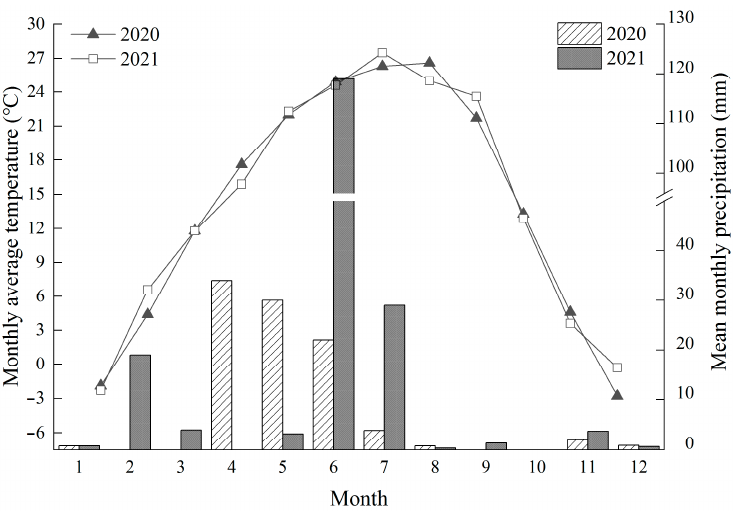
Figure 1. Monthly mean precipitation and temperature from 2020–2021 at the experimental site.